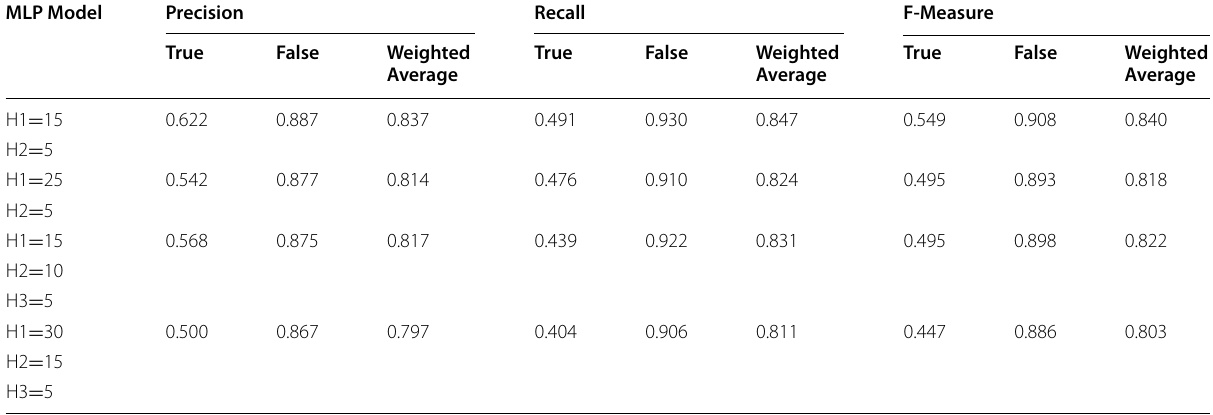
Table 7 Results obtained for mcMMO 1.4.06 dataset